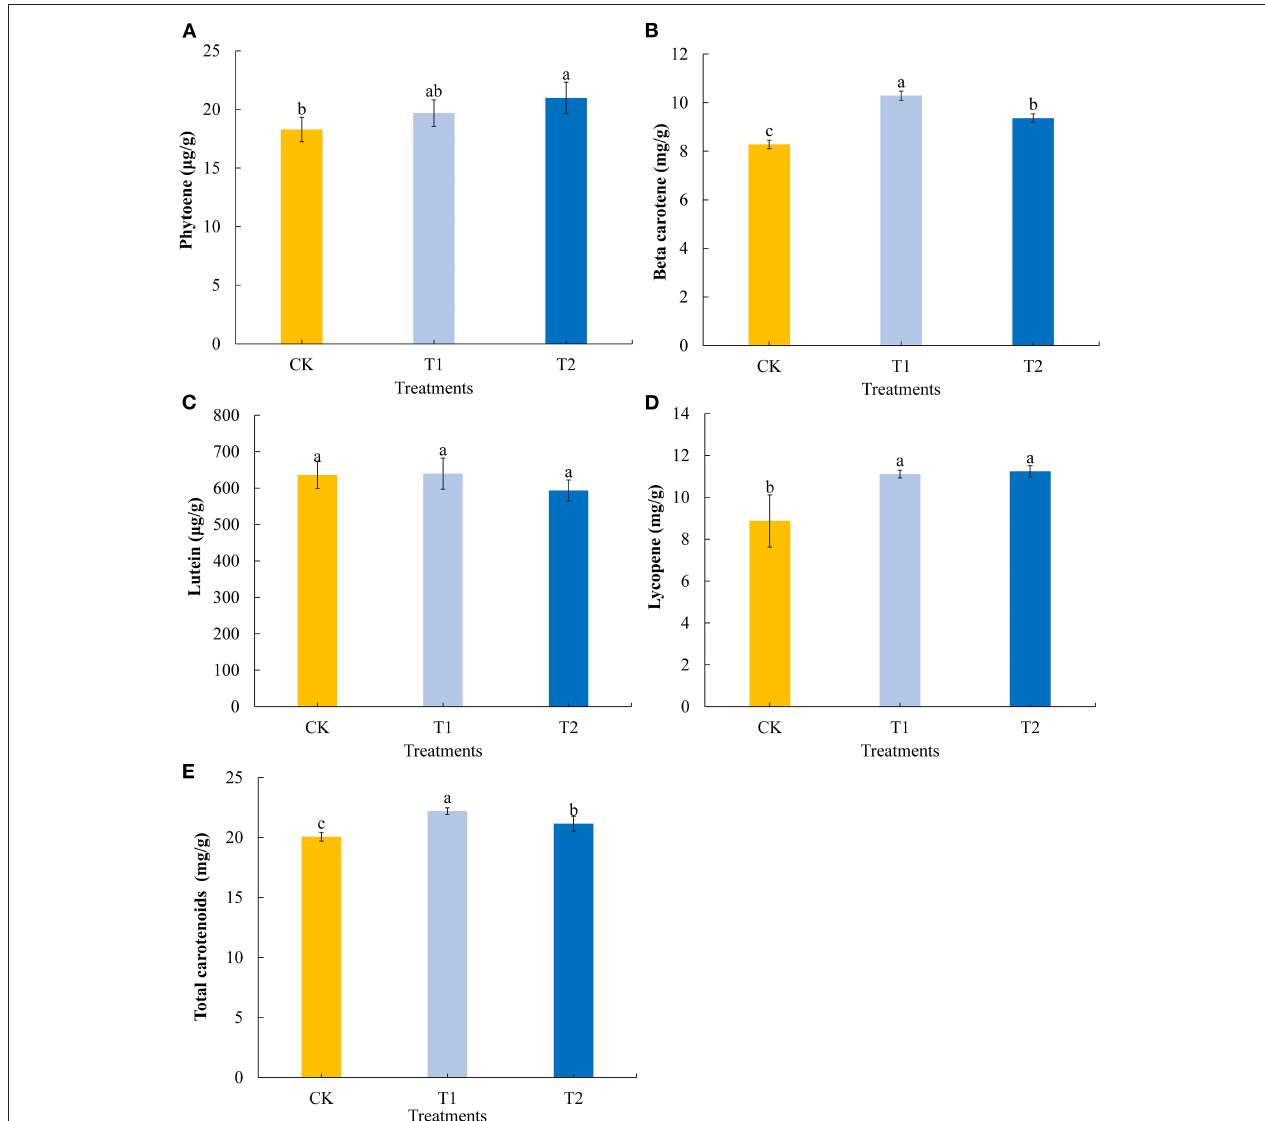
FIGURE 5 | Phytoene (A) , beta carotene (B) , lutein (C) , lycopene (D) , and total carotenoids (E) contents in tomato fruits under different LED supplementary light periods. The data are expressed as average values ± SD ( n = 3). a − c Indicate significant differences between treatments (P < 0.05, Duncan’s multiple range test). The bars indicate standard errors were indicated by bars. CK, no light supplementation control; T1, light supplementation for 3h in the morning; T2, light supplementation for 3h in the